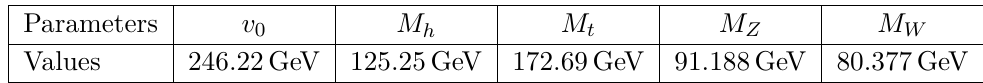
Table 1 . Collection of SM mass and VEV values taken from ref. [5]. At leading order the VEV